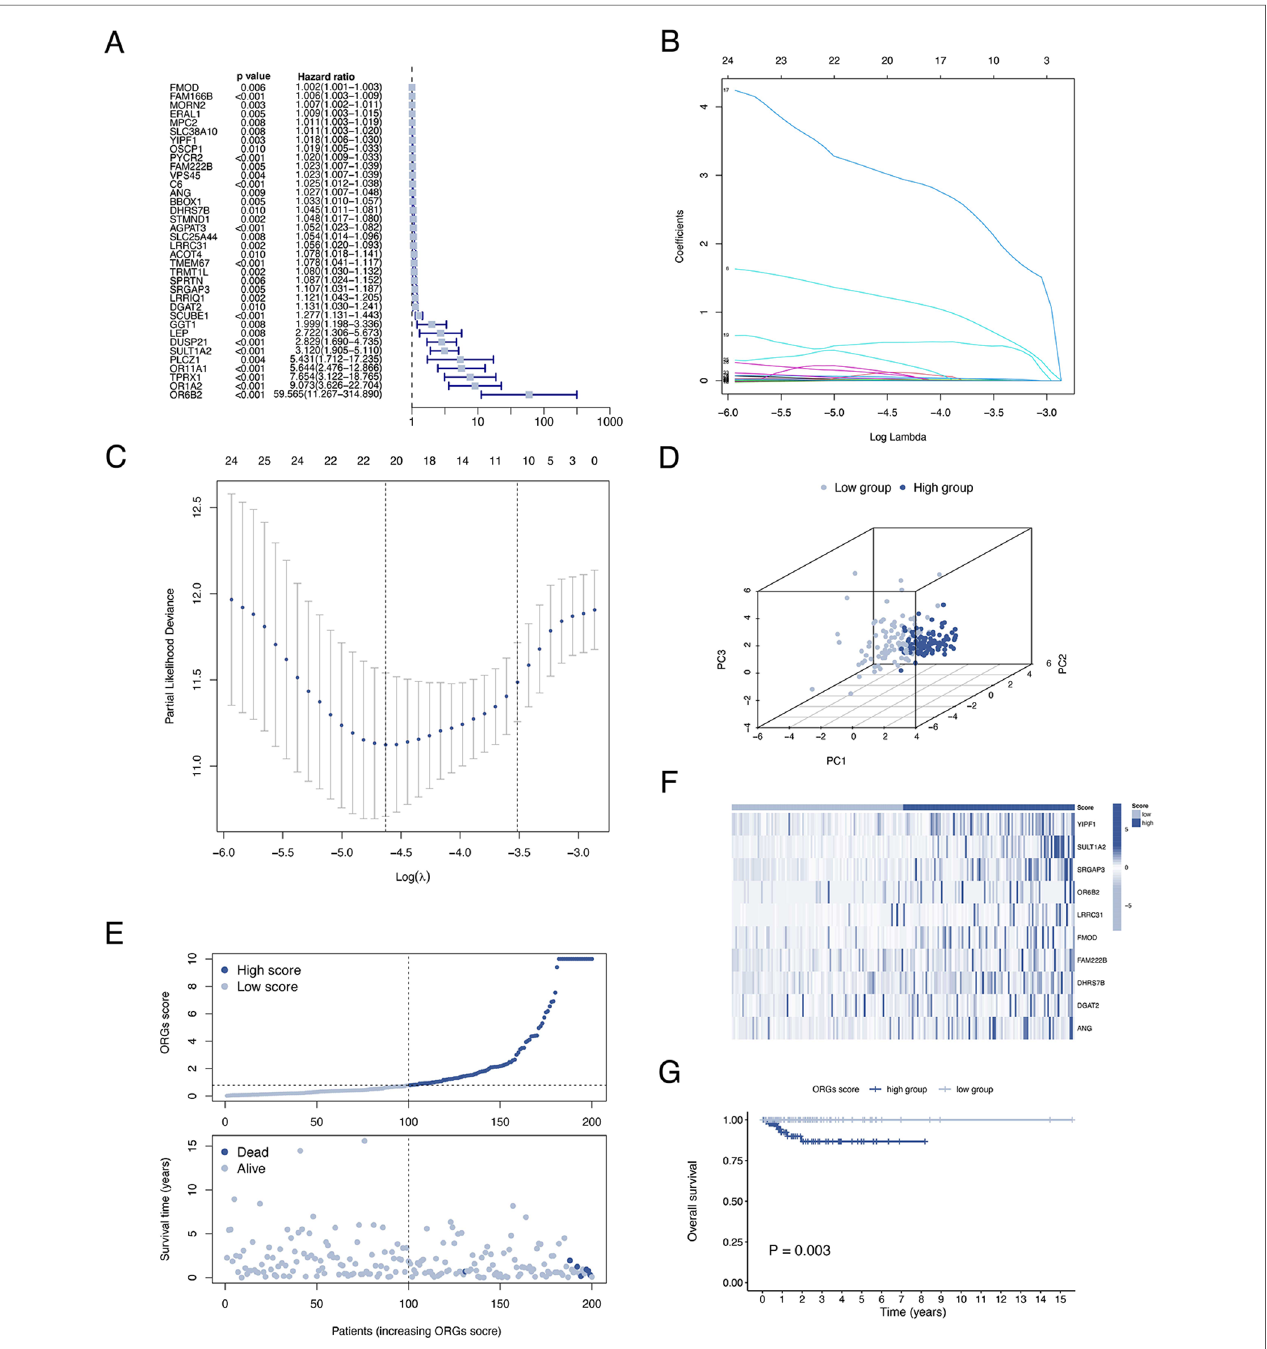
FIGURE 3 Establishment of the ORGs signature in the train cohort. ( A ) Univariate Cox regression analysis for screening prognostic ORGs. ( B,C ) LASSO regression analysis for variable selection and avoid over fi tting. ( D ) PCA plot for different ORGs scoring groups. ( E ) Scatter diagram for the ORGs score and survival status of EEC patients. ( F ) Heat map for the key 10 ORGs expression with ORGs grouping. ( G ) Kaplan – Meier curves of survival difference between two groups. ORGs, obesity-related genes. LASSO, least absolute shrinkage and selection operator. PCA, principal component analysis. EEC, endometrioid endometrial